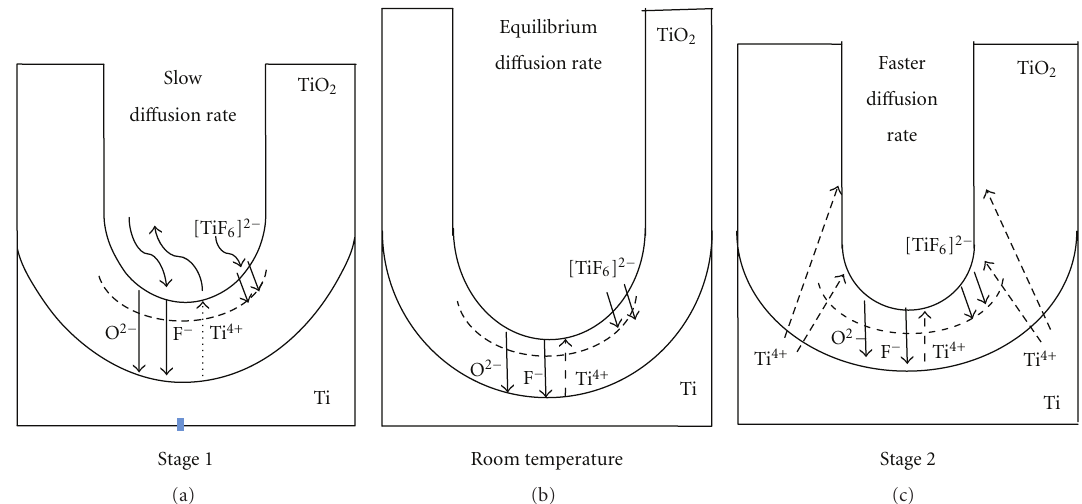
Figure 4: Schematic illustration explaining the di ff usion rate of ionic species at metal-oxide layers above the Ti foil, (a) Stage 1 (cool condition), (b) room temperature (27 ◦ C), and (c) Stage 2 (warm condition).